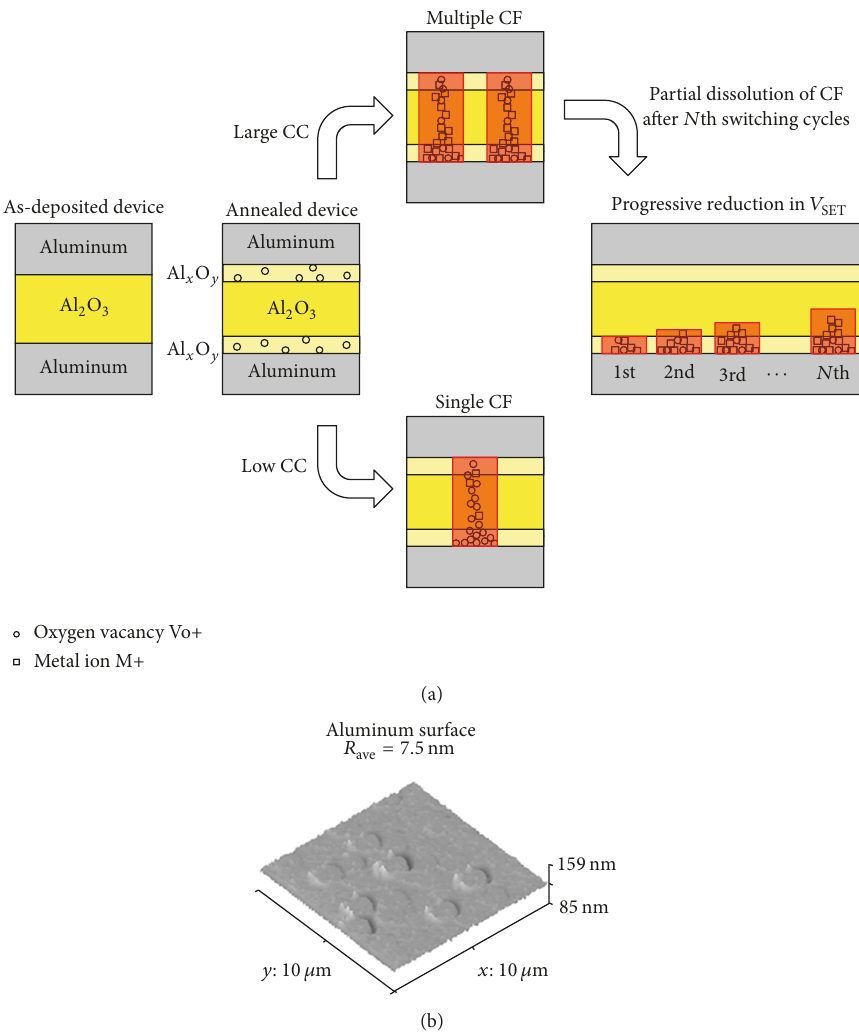
Figure 7: (a) Proposed physical mechanism for the origin of single and/or multiple conductive filaments (CFs) for Al/Al 2 O 3 /Al structure during the SET process (depending on the current compliance limit) and the effect that partial dissolution of this previously formed CF has on the progressive reduction of 𝑉 SET . For larger CC, multiple formation of CFs should be expected, with their composition being mostly based on metal ions [M + ]. (b) Average surface roughness of the BE (after AFM) showing large surface roughness which is close to the physical Al 2 O 3 thickness of the MIM device. High surface roughness would promote local electric-field